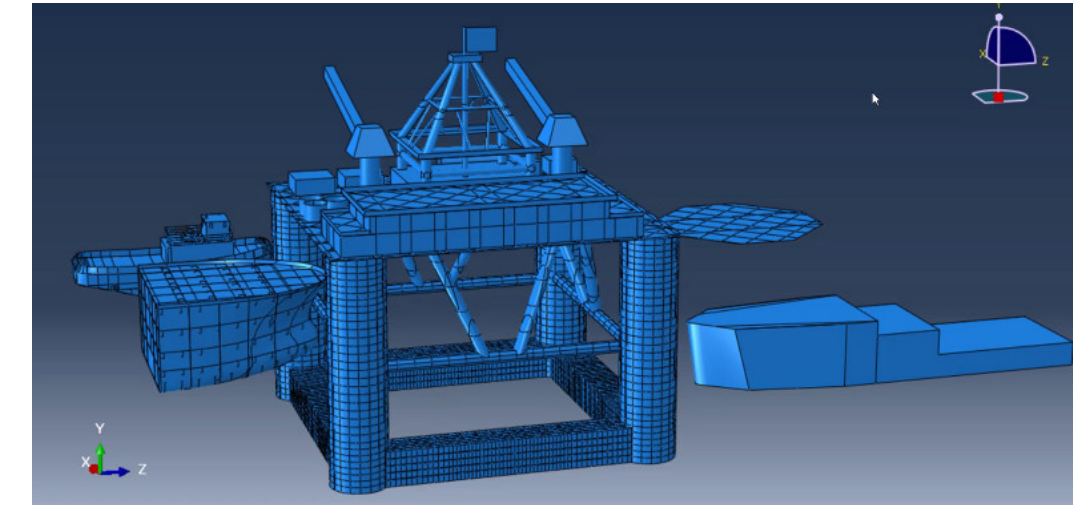
Figure 11. Ship collision scenarios. Table 6. Main properties of ship collision.